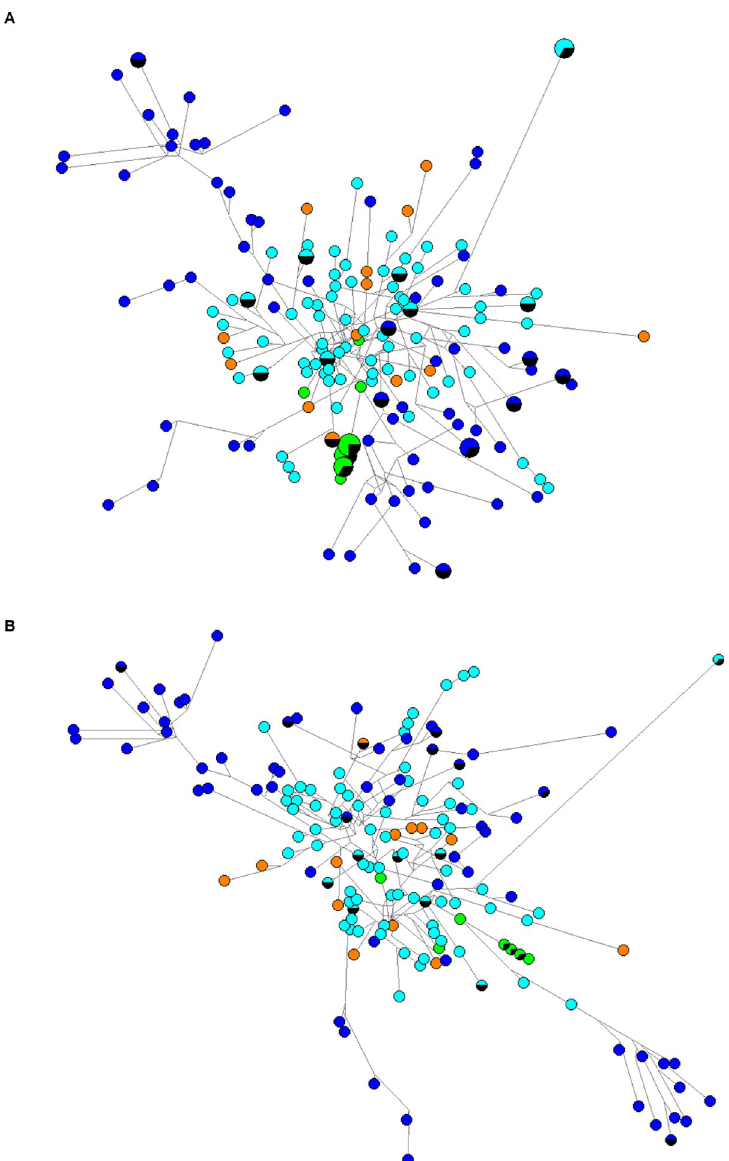
Fig 4. Median joining networks of all Cypriot haplotypes, which were assigned to Y-haplogroup J2a. (A) MJN among all Cypriot 17 Y-STR haplotypes assigned to Y haplogroup J2a. (B) MJN among all Cypriot haplotypes after the Star contraction option. MJN after the star contraction option is more simplified and expansion events are easy to be analyzed. The edges (lines) represent the mutation distance between individuals and the nodes (circles) represent the frequency of each haplotype. Two constructed networks are shown, where the dark blue indicates Turkish Cypriots, light blue Greek Cypriots, green Maronite Cypriots and orange Armenian Cypriots haplotypes.